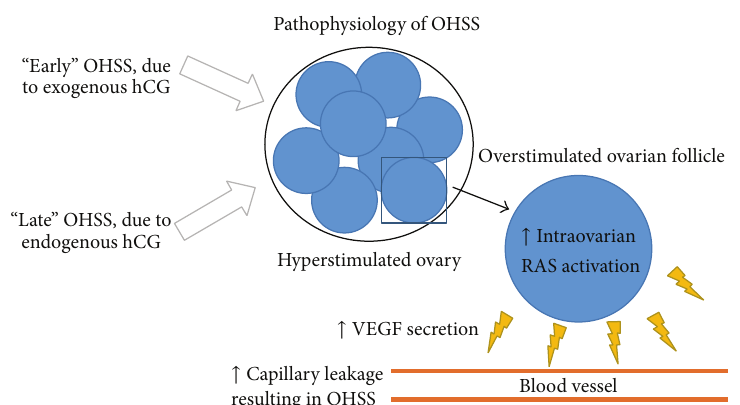
Figure 1: Graphical representation of the pathophysiology of ovarian hyperstimulation syndrome